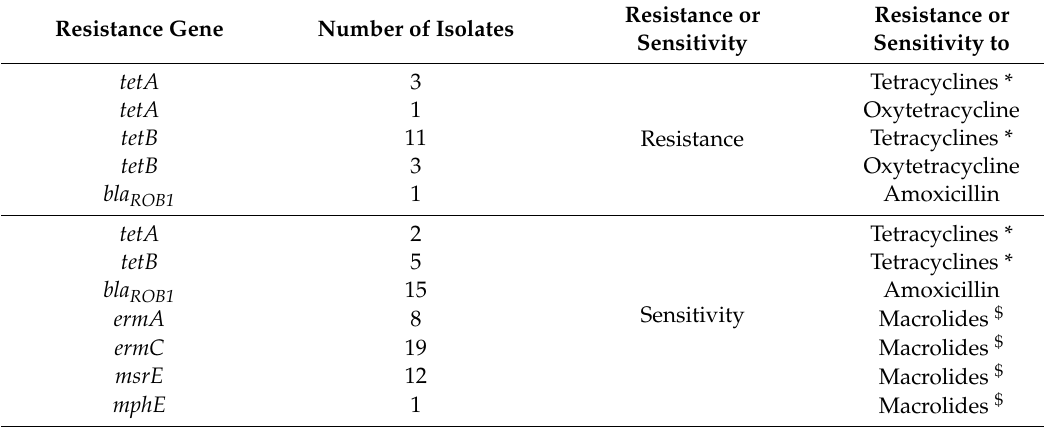
Table 3. Association between the presence of resistance genes and antimicrobial susceptibility patterns in 48 Pasteurella multocida isolates.